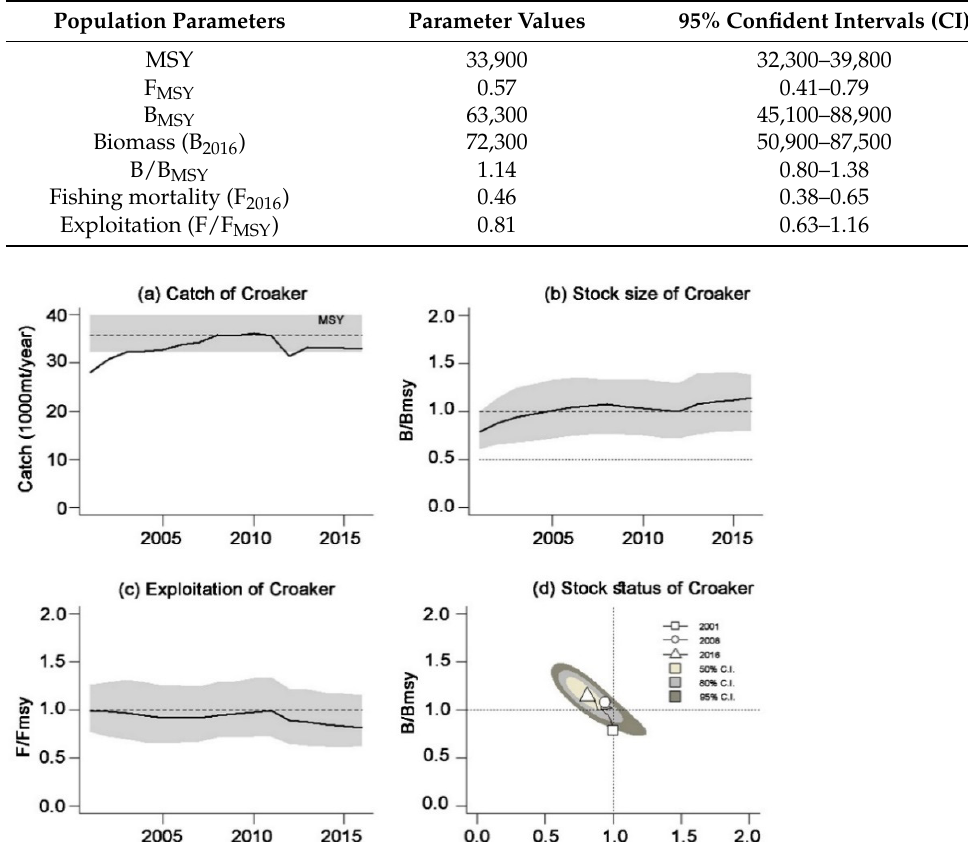
Table 4. Management information of croaker in the BoB produced by BSM method.